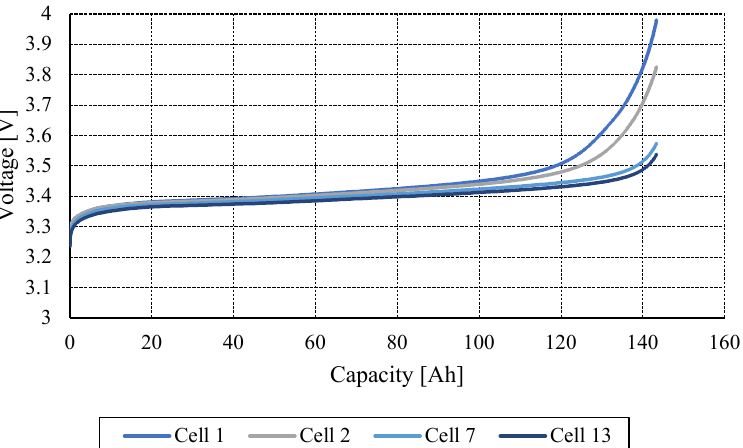
Figure 5. Example of four cells from the same battery pack of a total of 14 cells; adapted from [30].